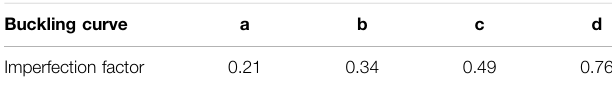
TABLE 3 | Sections of each component. Components Sections and